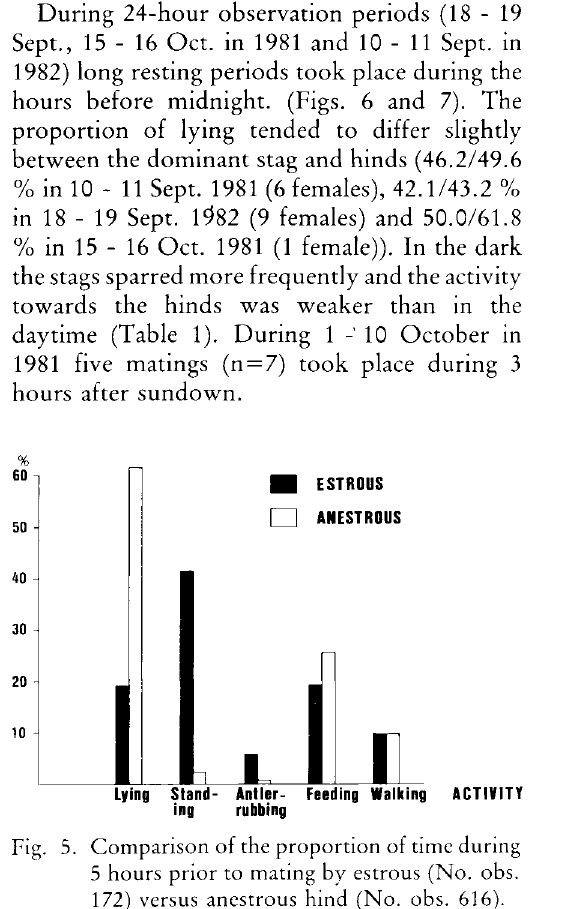
Fig. 5. Comparison of the proportion of time during 5 hours prior to mating by estrous (No. obs. 172) versus anestrous hind (No. obs.